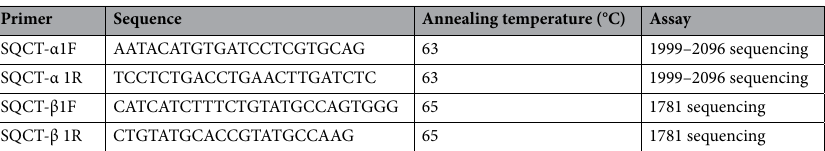
Table 1. Primers used for sequencing of the acetyl coenzyme A carboxylase gene in resistant (R) and susceptible (S) winter wild oat biotypes. The amino acid numbering follows the Alopecurus myosuroides chloroplastic ACCase sequence (Genbank biotype no.